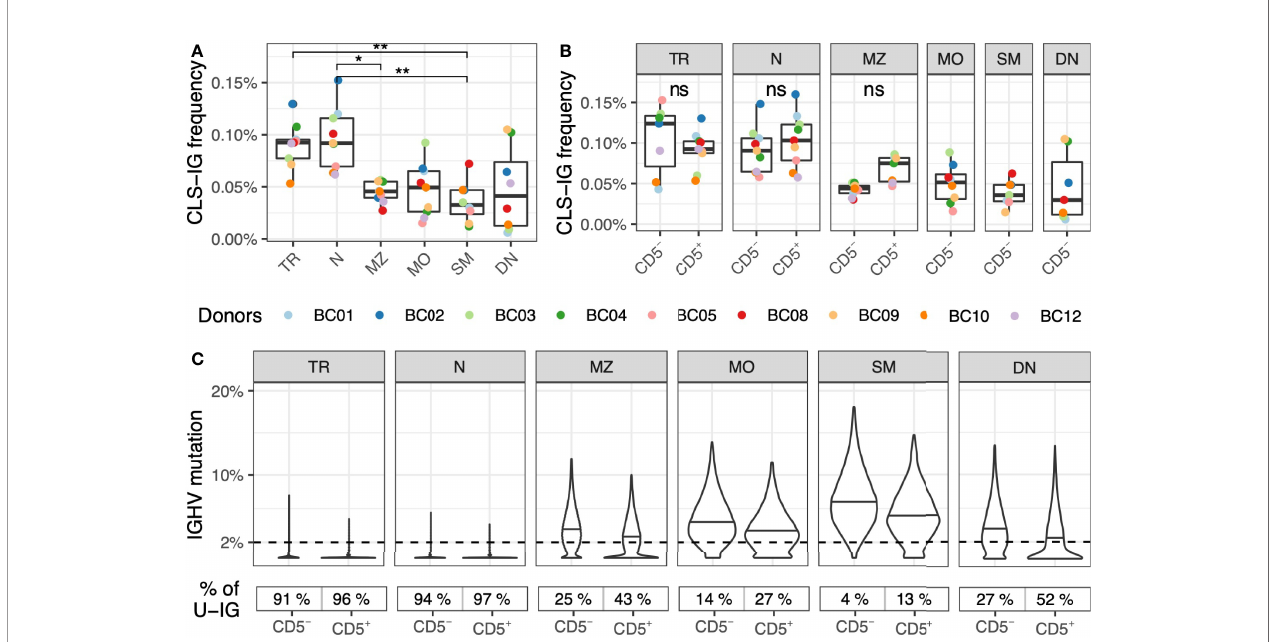
FIGURE 3 | Frequency of CLS-IG in circulating B-subset. (A) Frequency of CLS-IG in B-subset (B) . Frequency of CLS-IG in the same B-subset fractionated further for CD5 + and CD5 – B cells. Paired Wilcoxon test was performed, only signi fi cant statistics are shown (*p ≤ 0.05, **p ≤ 0.01; ns, not signi fi cant). CLS-IG identi fi ed in the CD5 + fraction of MZ, MO, SM, and DN B cells were insuf fi cient for statistical analysis. (C) IGHV genes mutation distribution in the B cell subsets-sub divided by CD5 expression. The percentage of unmutated IGs (< 2%) in each B cell population is shown at the bottom of the fi gure.